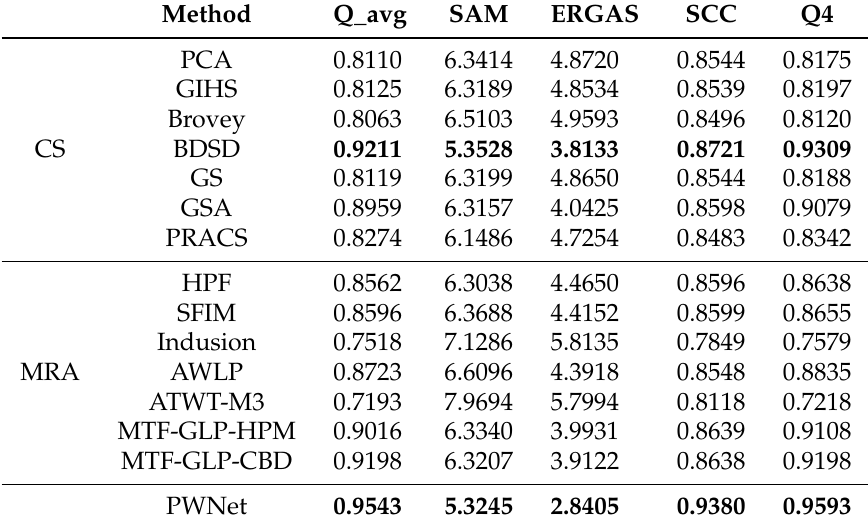
Table 6. Quantitative comparison of the CS-based and MRA-based methods and the proposed PWNet method on the GeoEye-1 images. The best and second best results are highlighted in